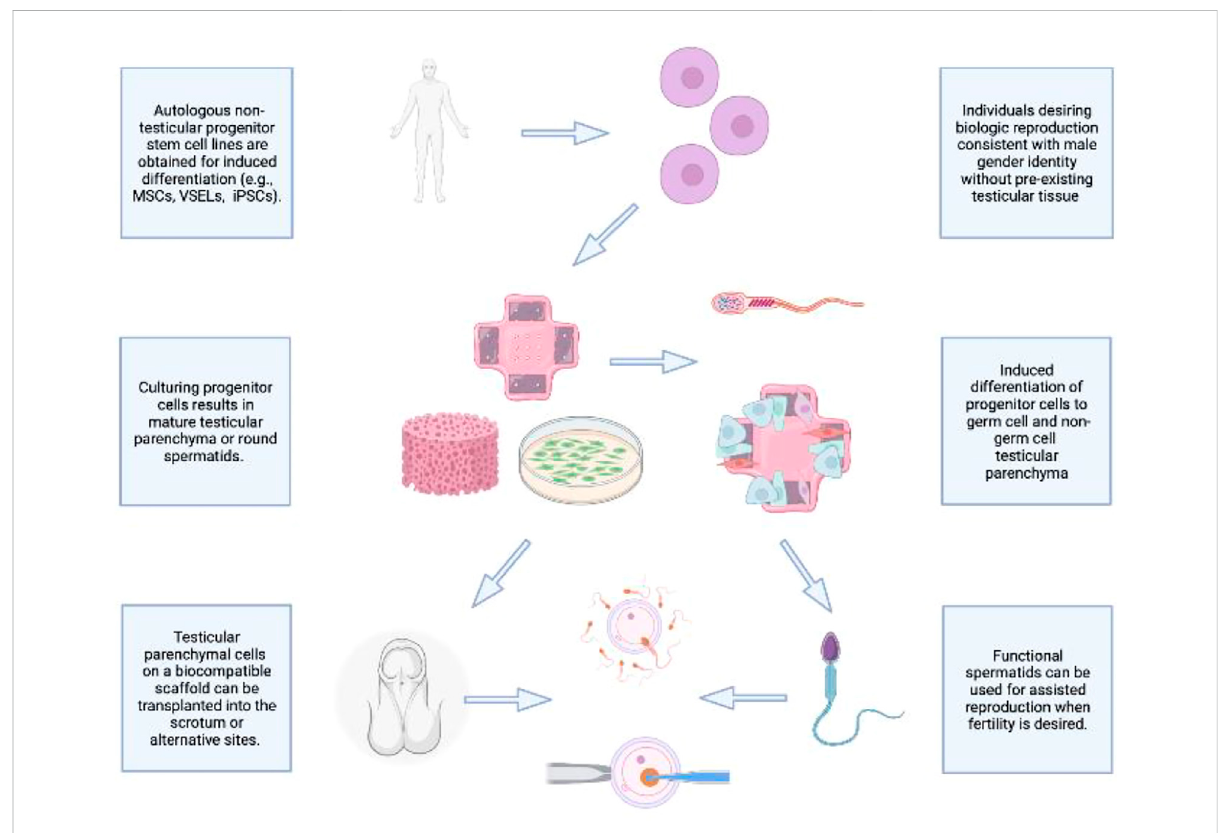
FIGURE 1 Envisioning the future of de Novo testicular tissue